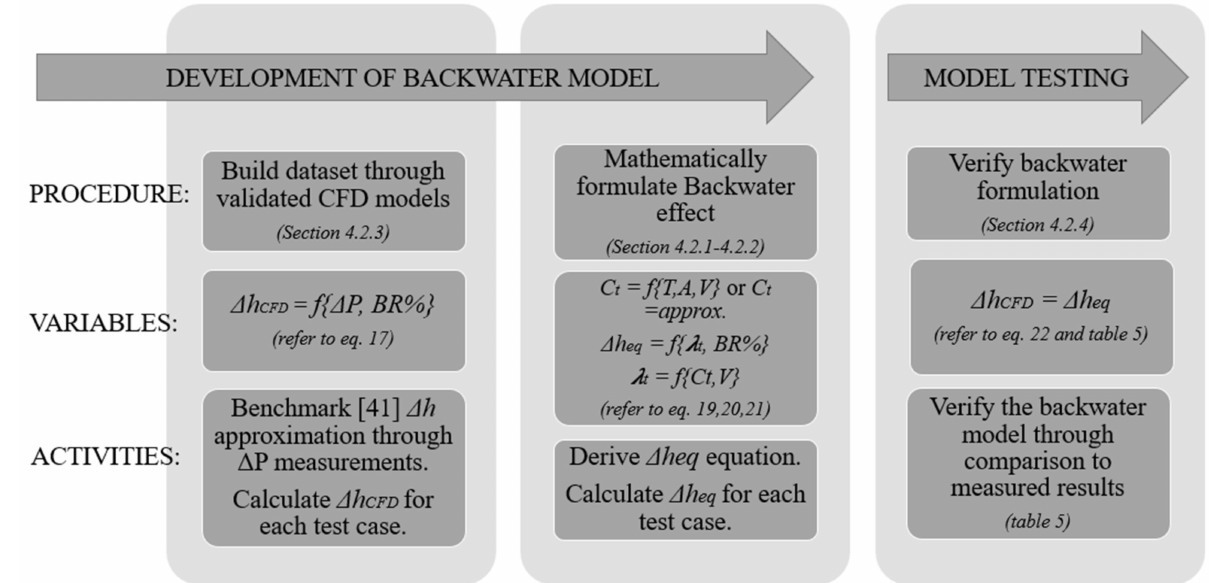
Figure 8. Workflow of backwater model